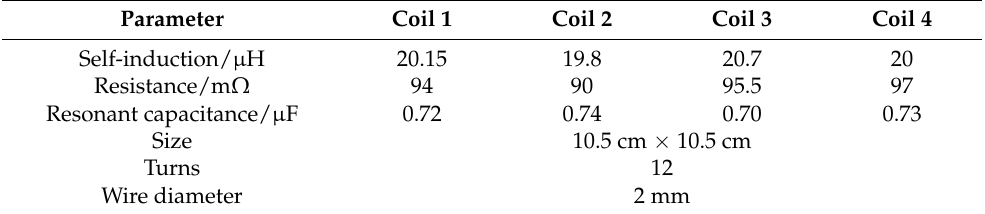
Table 5. Detection coil and resonant compensation capacitance parameters.